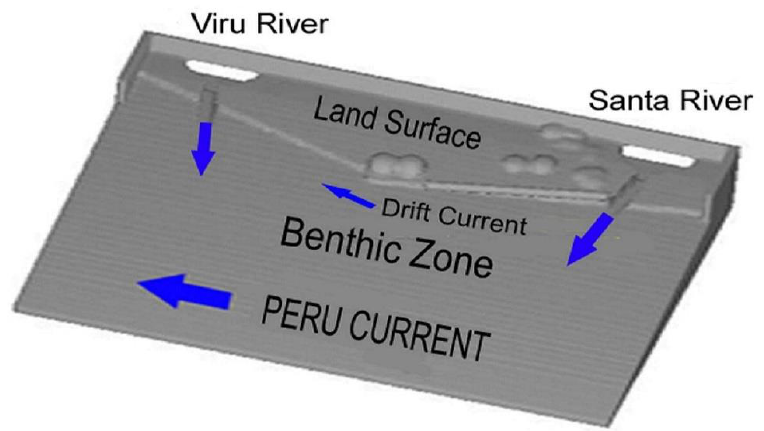
Figure 28. FLOW-3D CFD coastline model from the Santa to Viru River Valleys. FLOW-3D CFD model by author [2], p. 243.